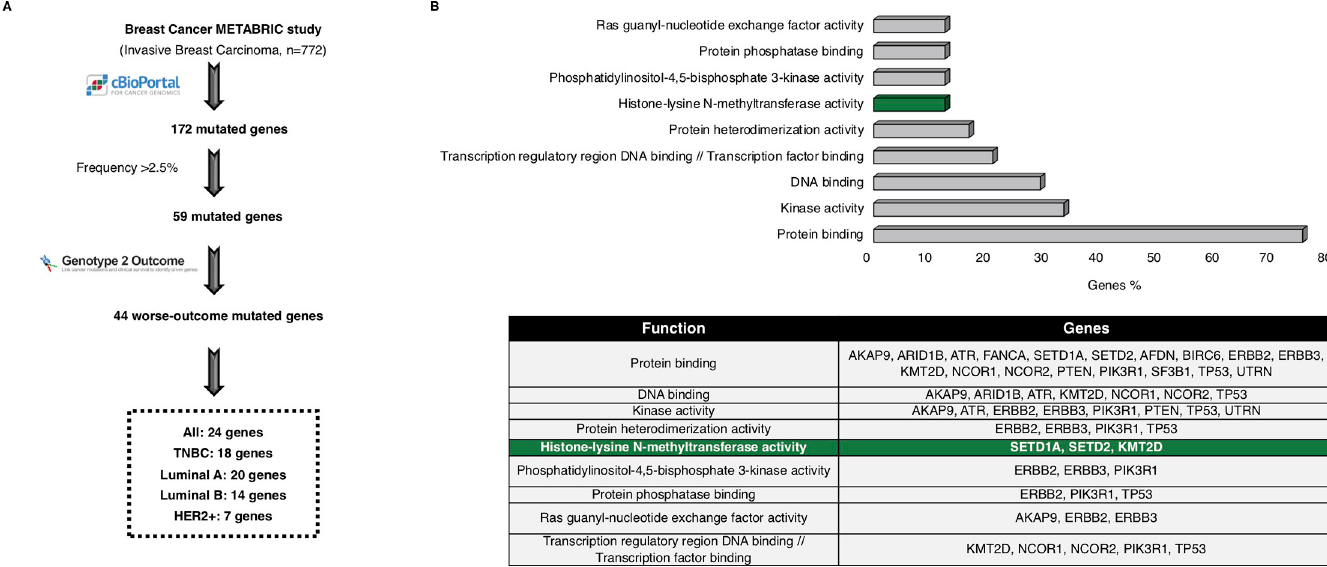
Fig 1. Whole genome mutational profiling and identification of histone-lysine methyltransferase activity as deregulated in breast cancer. A. Flow chart of the study, in which the METABRIC dataset was used to identify breast cancer mutated genes associated with worse outcome. B. Functional analyses of the mutated genes associated with worse outcome, using DAVID Bioinformatics Resources 6.8 tool, and found in more than 2.5% of the breast cancer samples analyzed. The table shows the list of the mutated genes contained in each function.